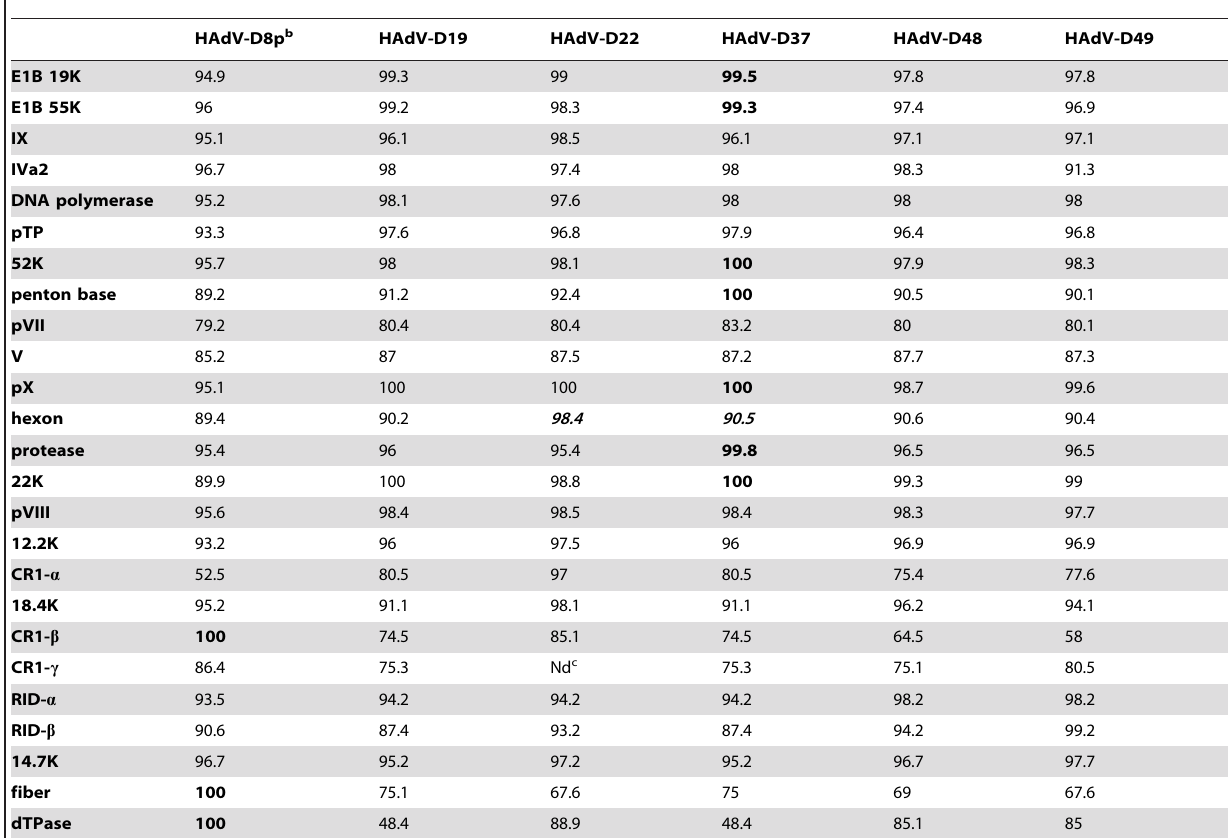
Table 1. Percent identities of the nucleotide coding sequences of selected HAdV-D53 proteins and their homologs a